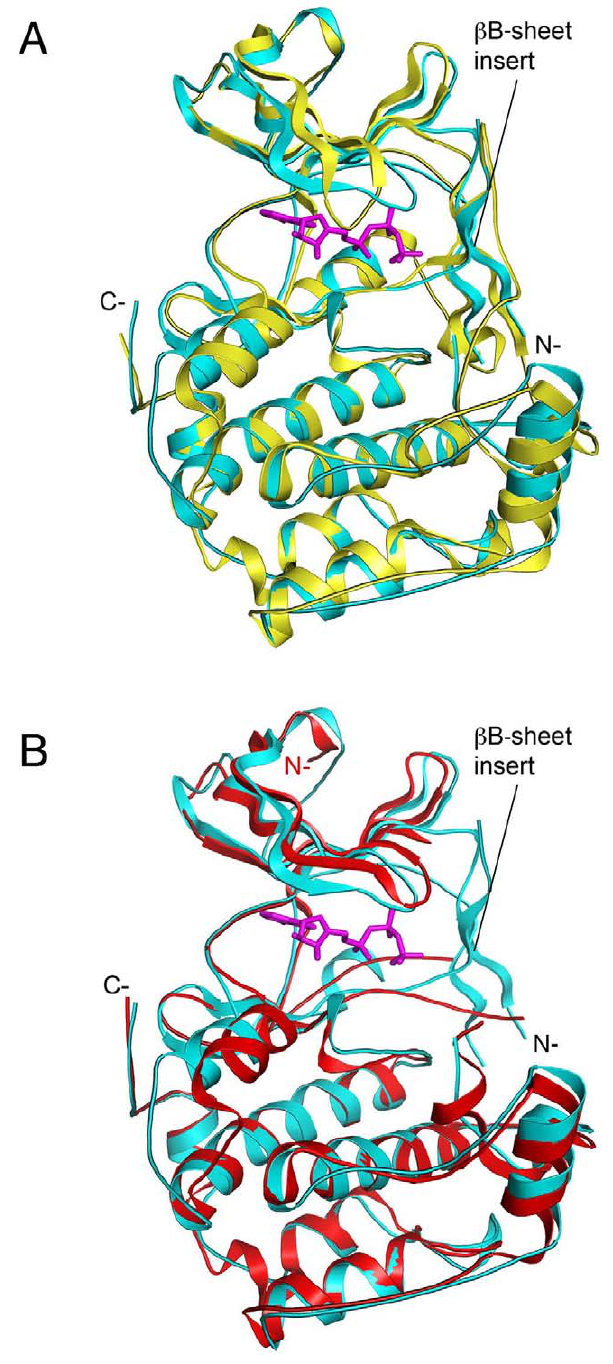
Figure 2. Superimposition of the N-terminal kinase domain of RSK2 with the similar domain of MSK1 (A) or RSK1 (B). The NTD RSK2 is shown in cyan in both (A) and (B). The inactive NTD MSK1 (PDB code 1VZO) is shown in yellow ( A ) and the inactive NTD RSK1 (PDB code 2Z7Q) is shown in red ( B ). The ATP molecule from the RSK1 structure is omitted. Obviously, the disordered region in RSK1 may accommodate the b B-sheet.